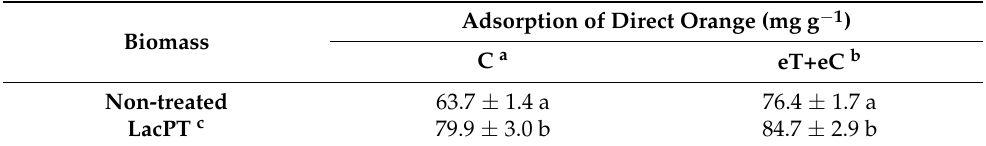
Table 2. The DO adsorption values for pretreated with crude laccase significantly increased ( p < 0.05) for both climate conditions compared to the respective non-treated biomass, indi- cating enhanced overall cellulose accessibility after crude laccase pretreatment, from which the main effect is to modify and remove lignin. This result agrees with the hydrolysis data in which pretreated substrates showed the highest bioconversion rates (Figures 4, 6 and 7). Table 2. Direct orange dye adsorption of non-treated and pretreated P. maximum samples in different clime conditions.